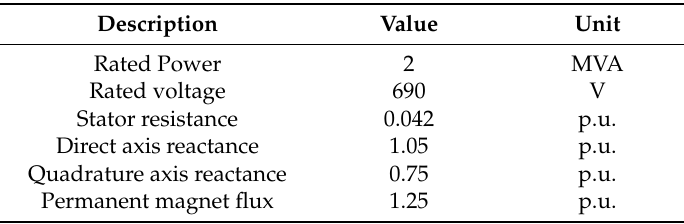
Table 1. Permanent magnet synchronous generator (PMSG) data.